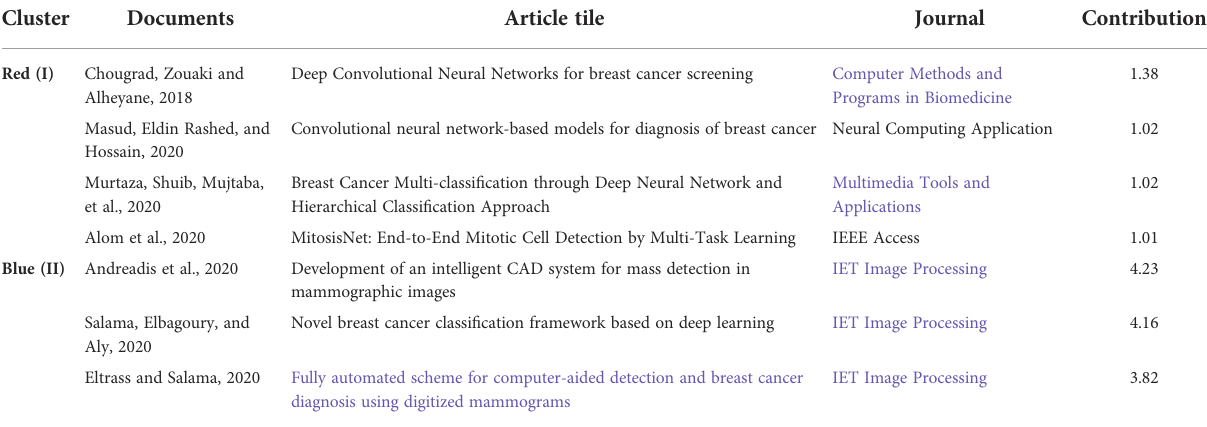
TABLE 5 Highly contributing Articles by clusters obtained using Multicorrespondence